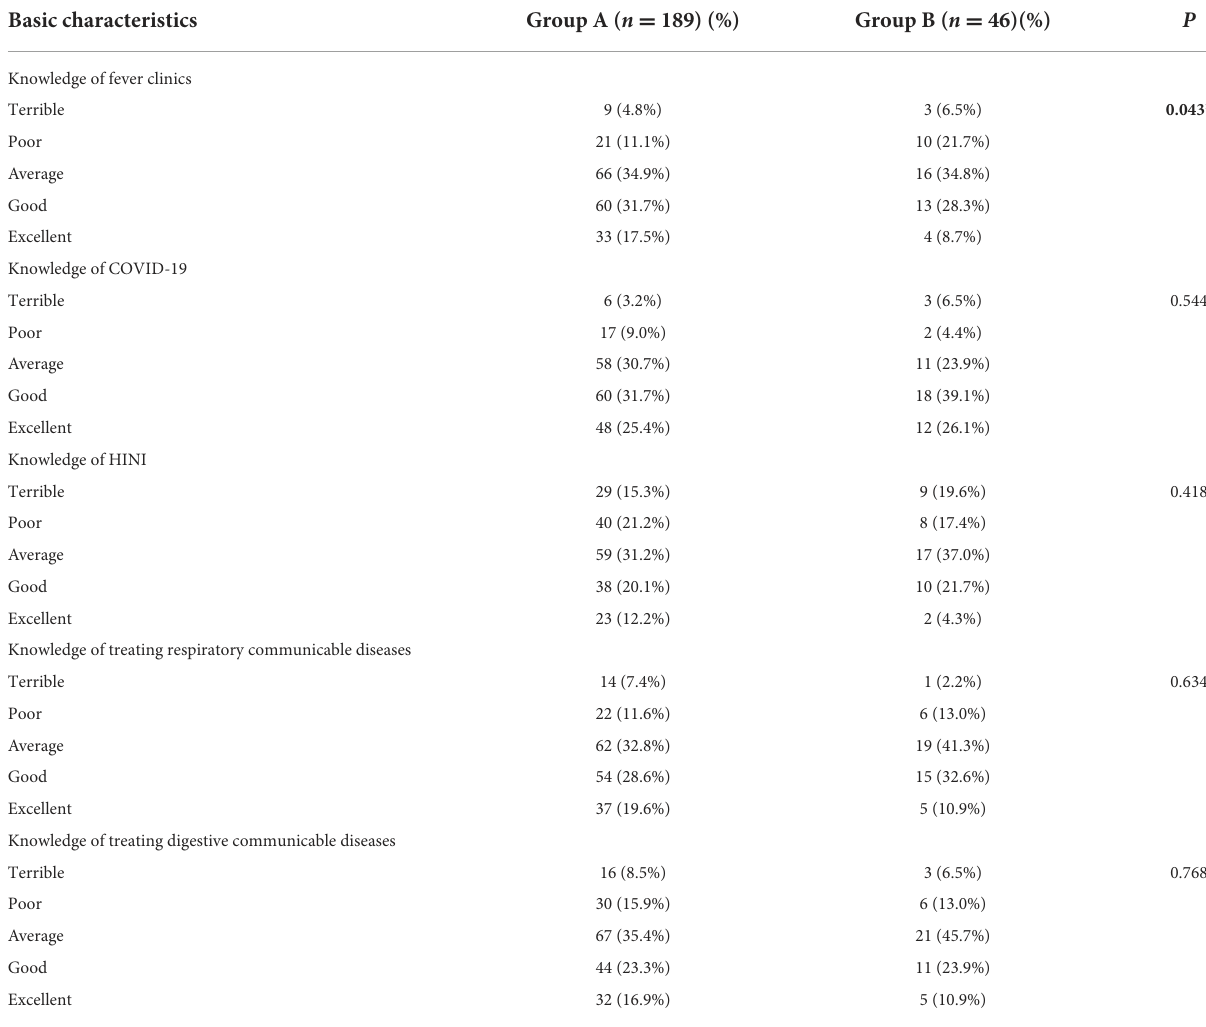
TABLE 4 Comparison of the knowledge of communicable diseases associated with public health emergencies between clinical and preventive medical students. Basic